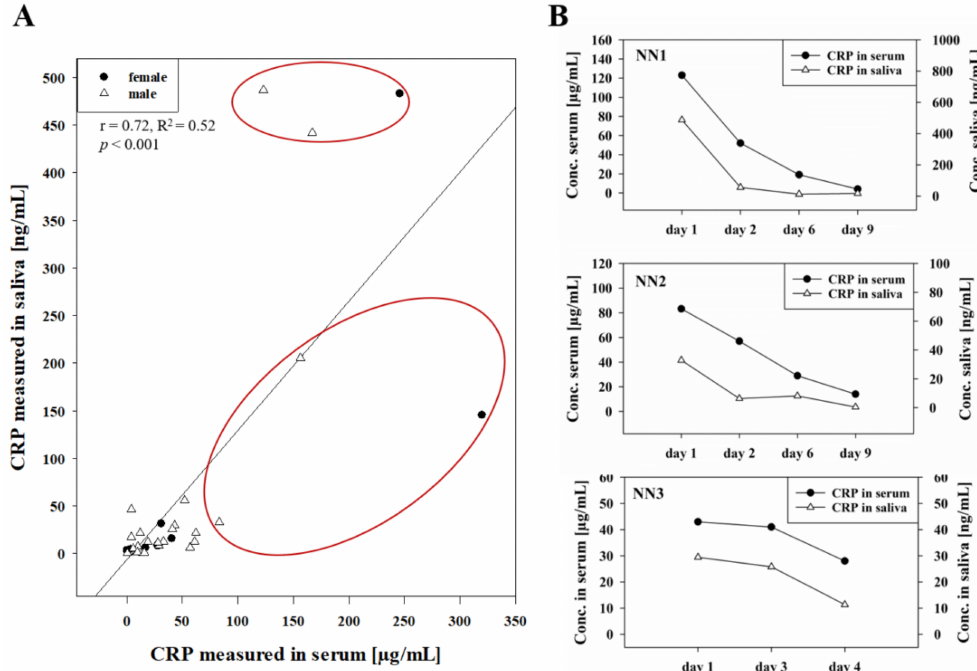
Figure 1. CRP concentration in serum [ µ g/mL] and corresponding concentration in saliva [ng/mL] of 18 neonates (gestational age at birth 33.10 ± 5.44 weeks, six females) over 1–4 time points ( n = 33). Serum concentration of CRP was measured with 53.12 ± 72.82 µ g/mL (mean ± SD, maximum at 320 µ g/mL and minimum at 0.3 µ g/mL). Salivary CRP was measured with 65.73 ± 137.70 ng/mL (mean ± SD, maximum at 489 ng/mL and minimum at 0.12 ng/mL). Pearson’s correlation was calculated as r = 0.72 ( p < 0.001) with y = − 6.388 x + 1.358, R 2 = 0.52. Concentrations indicating severe sepsis (>80 µ g/mL CRP in serum) were circled in red ( A ). Time course of measured salivary [ng/mL] and serum [ µ g/mL] CRP concentration over 4–9 days from three selected neonates (NN1–NN3) with gestational age of 29 + 1, 35 + 0, and 30 + 1 (week + day) ( B